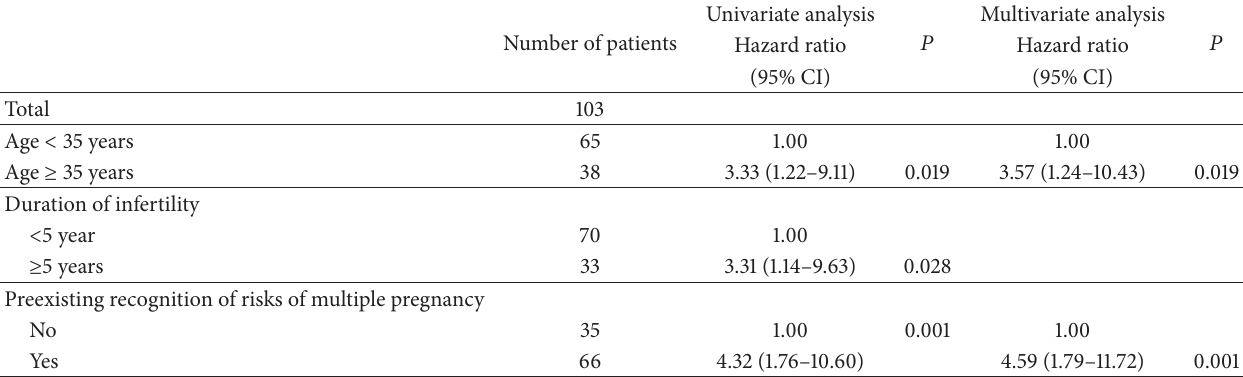
Table 4: Univariate and multivariate analysis of predictors for a continuous desire of multiple pregnancies